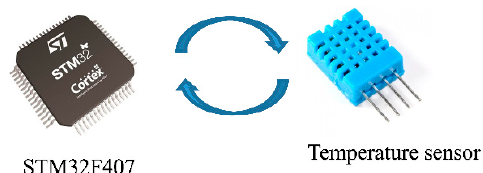
Figure 5. Temperature measurement module of the portable smart spectrometer.